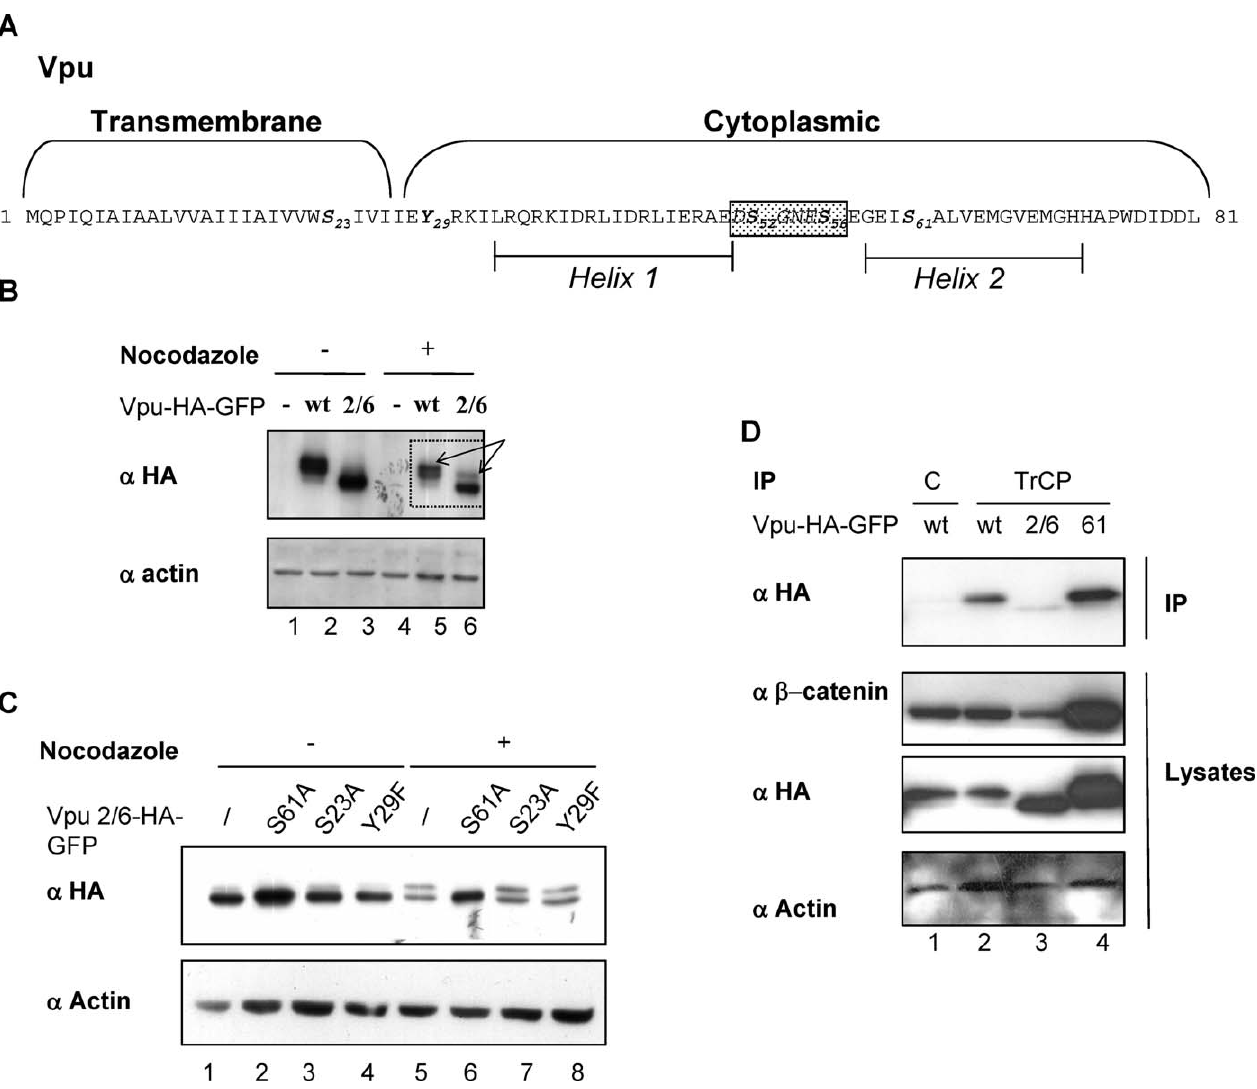
Figure 3. Identification of a New Phosphorylation Determinant in Vpu (A) Schematic representation of the Vpu sequence from the HIV-1 NL4–3 strain. Potential phosphorylation residues are indicated in bold. These include two serine residues (S23 and S61) and one tyrosine (Y29), in addition to the S52 and S56 present in the boxed b TrCP-binding motif. (B) A new form of Vpu and Vpu 2/6 is detected in nocodazole-treated cells. HeLa cells were mock-transfected (lanes 1 and 4), transfected by Vpu-HA- GFP (lanes 2 and 5), or by Vpu 2/6-HA-GFP (lanes 3 and 6). 24 h after transfection, cells were treated 18 h with nocodazole (lanes 4–6) or with DMSO (lanes 1–3). Cell lysates were separated by SDS-PAGE and analyzed by western blot using the indicated antibodies. (C) Vpu is phosphorylated on serine 61 in nocodazole-treated cells. HeLa cells were transfected with the indicated Vpu variants: Vpu2/6-HA-GFP (lanes 1 and 5), Vpu2/6 S61A (lanes 2 and 6), Vpu 2/6 S23A (lanes 3 and 7), and Vpu 2/6 Y29F (lanes 4 and 8). Cells were treated during 18 h with nocodazole (lanes 5–8) or with DMSO (lanes 1–4). Cell lysates were separated by SDS-PAGE and analyzed by western blot using the indicated antibodies. (D) VpuS61A conserves its ability to interact with b TrCP. Lysates from HeLa cells expressing Vpu-HA-GFP (lanes 1 and 2), Vpu 2/6-HA-GFP (lane 3), or Vpu S61A-HA-GFP (lane 4) were immunoprecipitated with anti- b TrCP (IP TrCP, lanes 2–4) or with control antibodies (IP C, lane 1). Immunoprecipitates and cell lysates were separated by SDS-PAGE and analyzed by western blot using the indicated antibodies.